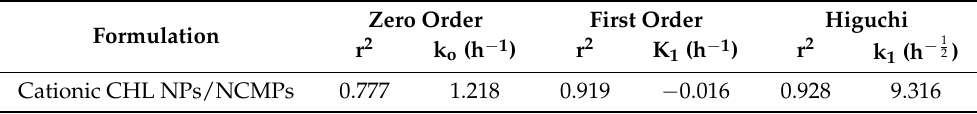
Figure 5. SDS-PAGE to evaluate the BSA stability released from cationic CHL NPs/NCMPs ( A ). Lanes represent, molecular weight (MW) standard markers, BSA (MW 66,000) ( 1 ), BSA standard ( 2 ), BSA released from hybrid cationic CHL NPs ( 3 ), and BSA released from cationic CHL NPs/NCMPs ( 4 ). Difference in band intensity was due to different loading. (The CD spectra of BSA released from cationic CHL NPs/NCMPs (grey) and BSA standard (black) ( B ) ( n = 3). The secondary structure of released protein from cationic CHL NPs/NCMPs was in- vestigated using CD. The CD spectra (Figure 5B) presents two minima between 221–222 and 209–210 nm. Furthermore, at 195 nm, a maximum was observed for standard BSA and BSA released, characteristic of an α -helical structure. The analysis further revealed that the BSA standard was primarily α -helical (51.5% helicity, Table 3), which was re- duced (circa 43 % helical, Table 3) for released BSA from cationic CHL NPs/NCMPs. Ad- ditionally, comparing released BSA with standard BSA (Table 3) indicated an 8.5% reduc- tion in α -helical content, an increase of 7.5 % in β -sheet content, a decrease of 2% in the turns content, and an increase of 3 % in the random coils’ content.